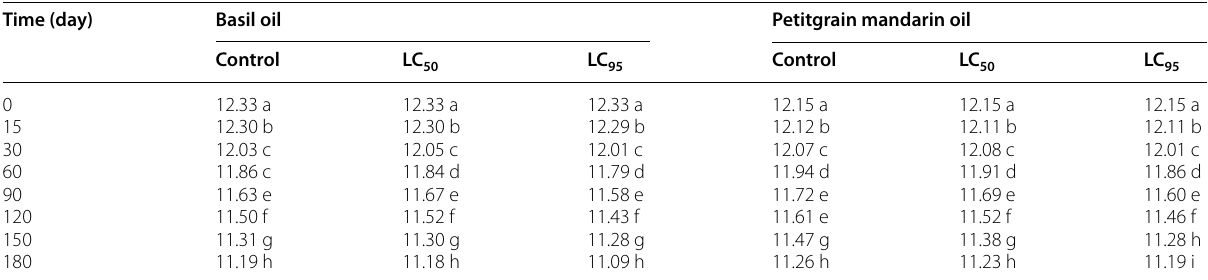
In the same column, means followed by the same letter are not significantly different at 0.05 level according to Duncan multiple range test